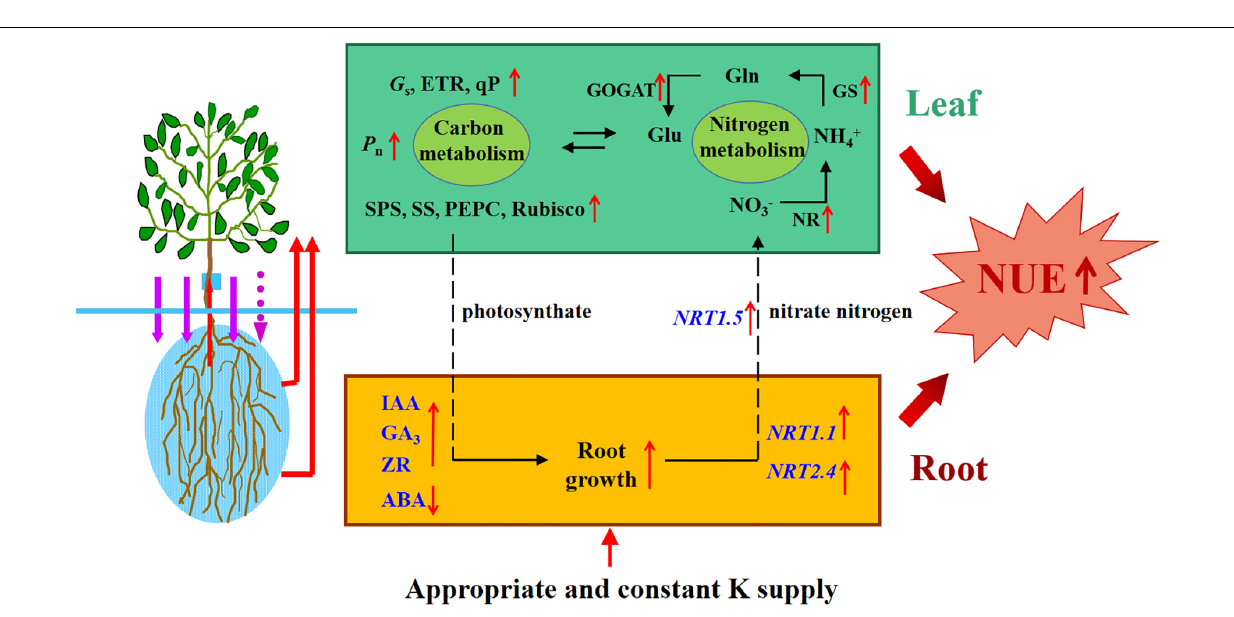
FIGURE 11 | Schematic model displaying the role of K on apple rootstock growth and Nitrogen and carbon metabolism. Appropriate and constant K supply promoted root growth and increased the activities of carbon and nitrogen metabolism enzymes, which promoted the N absorption and assimilation, meanwhile, thus increased the NUE of apple